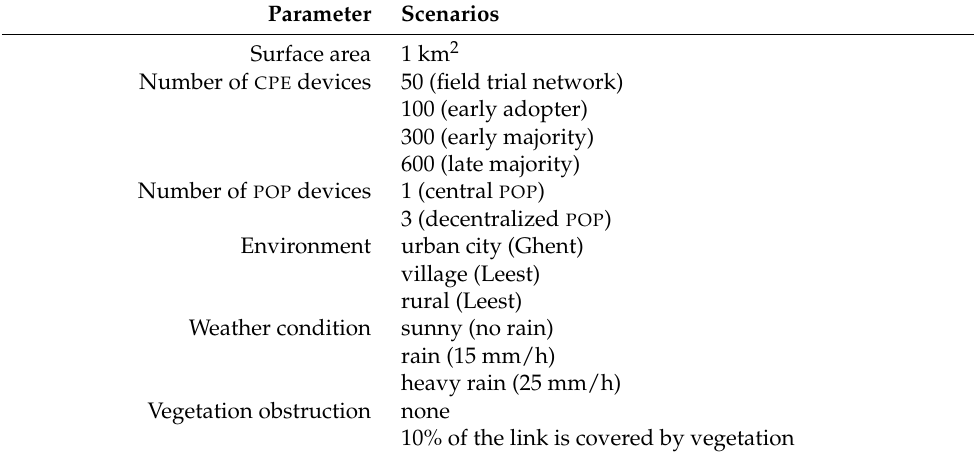
Table 3. Considered scenarios for FWA network analysis.